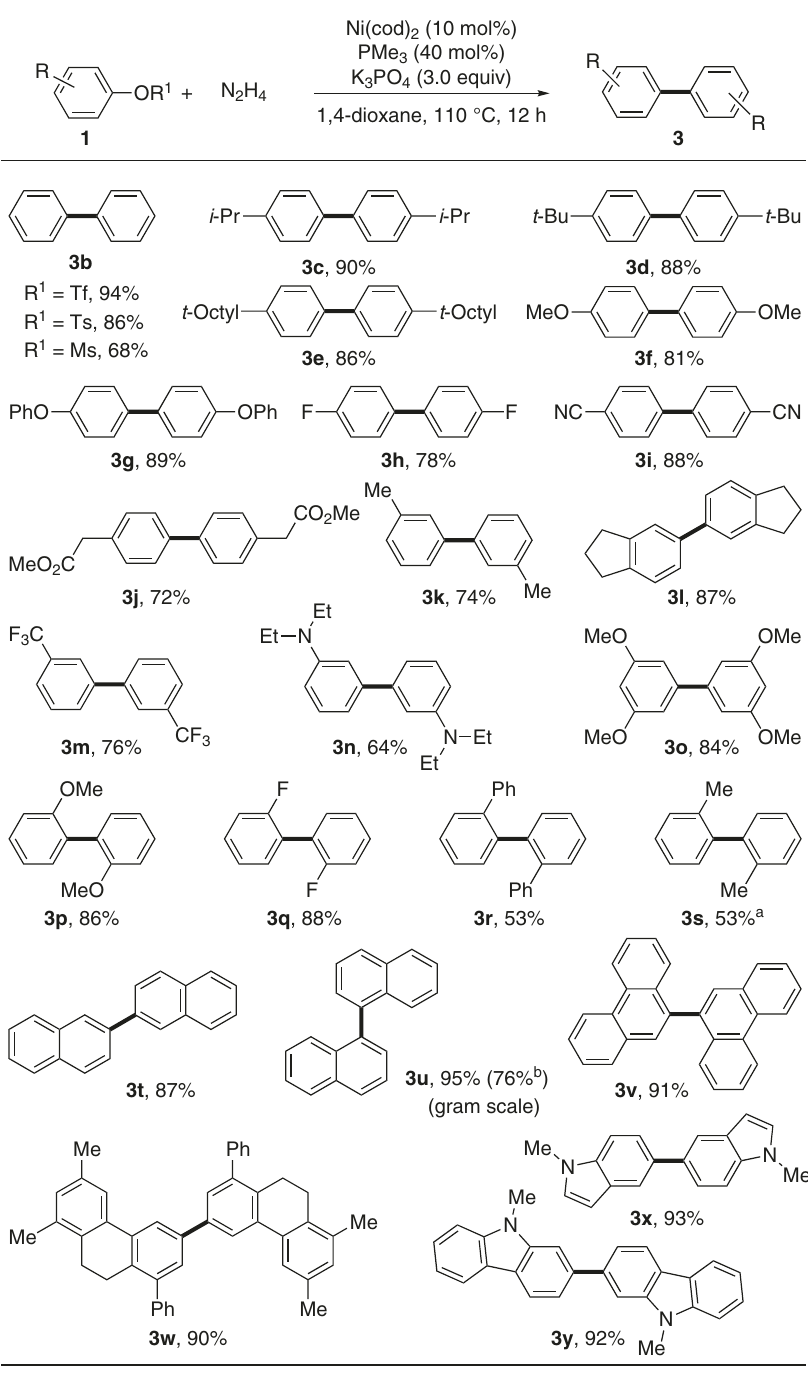
Fig. 3 Scope of aryl tosylates 1 . Reaction conditions: 1 (0.2 mmol), N 2 H 4 (0.1 mmol), Ni(cod) 2 (10 mol%), PMe 3 (40 mol%), K 3 PO 4 (0.6 mmol), 1,4- dioxane (1.0 mL), 110 °C, 12 h under N 2. . Reported yields are the isolated ones. a The reaction was carried out at 130 °C. b The reaction was carried out on 10 mmol scale, and 3u was obtained in 0.96